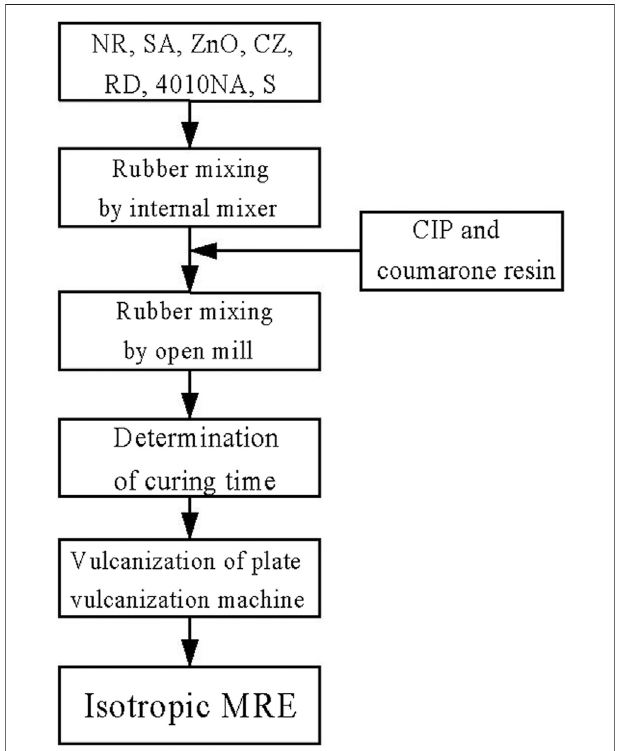
FIGURE 1 | Preparation process of